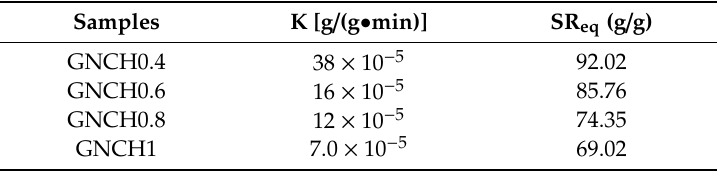
Table 1. Parameters obtained from swelling